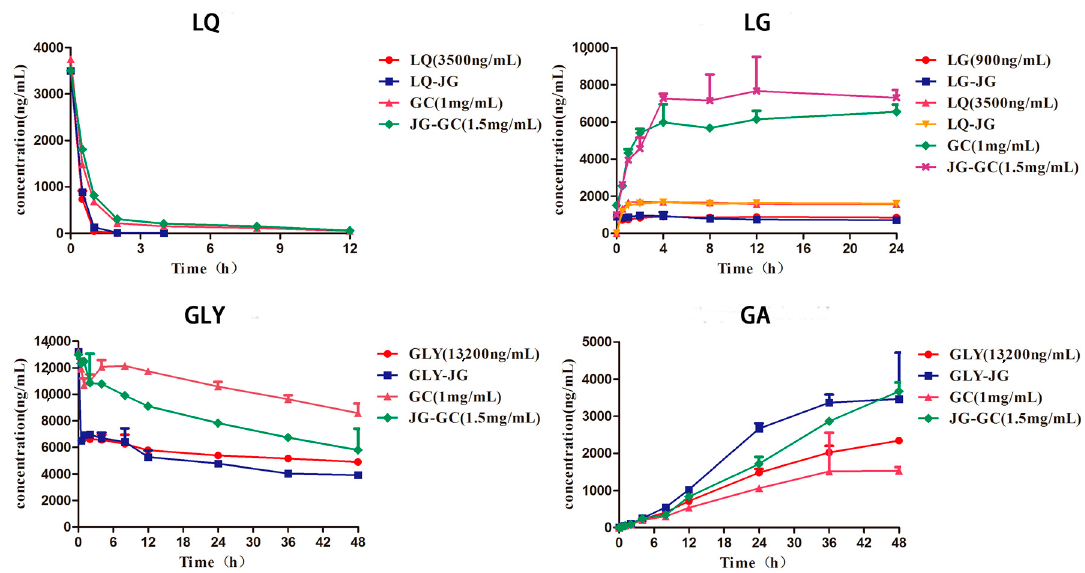
Figure 4. Hydrolysis of Gancao constituents in rat fecal lysates (mean ± SD; n = 3).